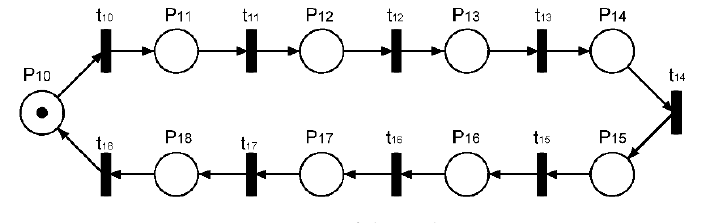
Figure 18. Petri net of the picking process.